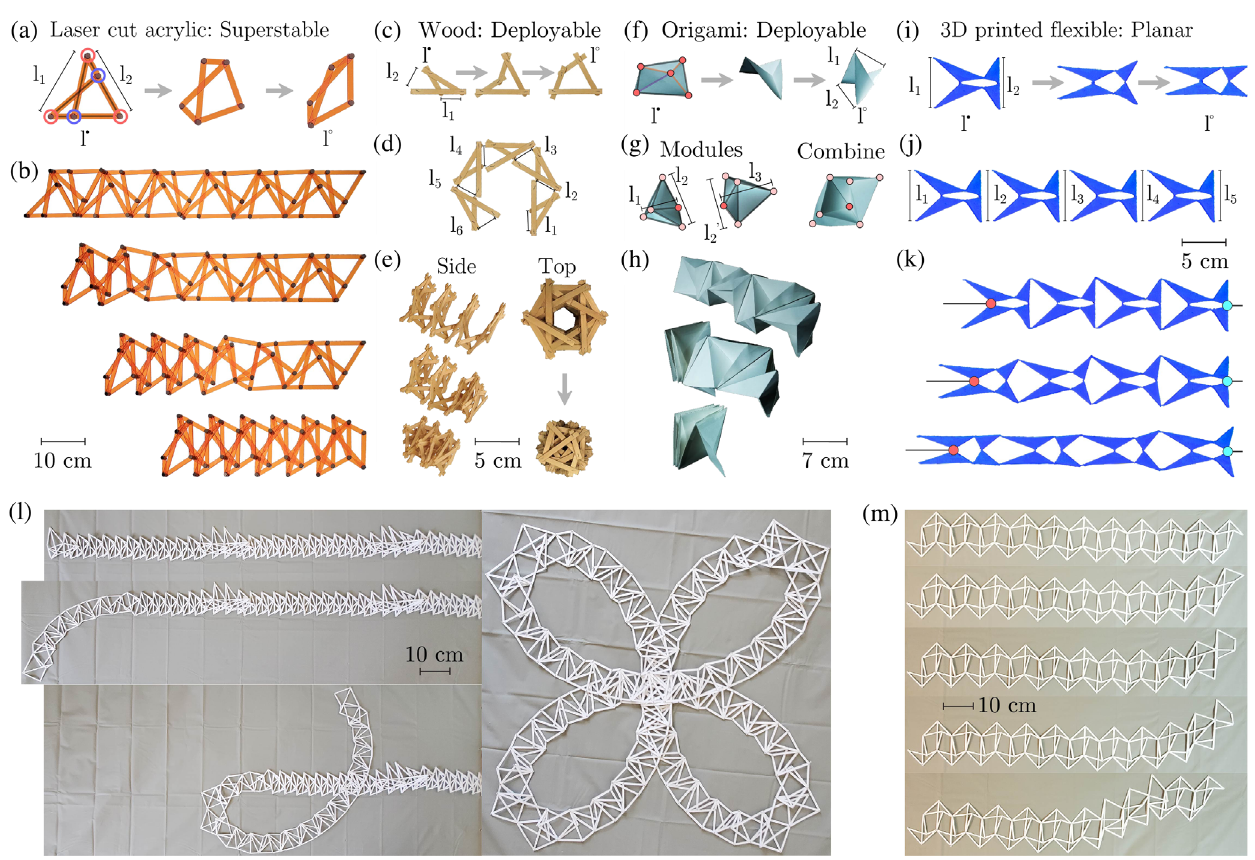
FIG. 14. Physical construction of networks. (a) Photo of a superstable unit constructed from laser-cut acrylic bars held together by Chicago screws at the joints, transitioning between two fixed points l (cid:129) and l ∘ . (b) Photos of a combined network collapsing from l (cid:129) to l ∘ . (c) A four-bar linkage with two fixed points l (cid:129) and l ∘ , (d) combined hexagonally into (e) an initially wide spiral helix with a channel l (cid:129) , collapsing sequentially to a narrow closed helix. (f) Photo of a creased square sheet of paper modeled as a linkage with one conformational motion moving between two fixed points l (cid:129) and l ∘ (purple is the mountain fold; orange is the valley fold). (g) Two creased sheets combined by merging the nodes defining l 2 and l 0 2 , along with a third node in each module marked in bright red. (h) Combined network of 12 sheets that sequentially collapses from the l ∘ to the l (cid:129) lattice. (i) A 3D-printed planar module with two fixed points l (cid:129) ; l ∘ . Each module is composed of triangles connected by a thin layer of material, which (j) form a chain where (k) fixing the cyan hinge and pulling the red hinge yields a sequential transition from l (cid:129) to l ∘ . (l) Photos of the quadrifolium and (m) chaotic networks made from cardstock bars held together by metal [Fig. 14(f), see Secs. VI and VII of Ref. [40] for the maps l k ¼ f ð l k Þ ]. þ 1